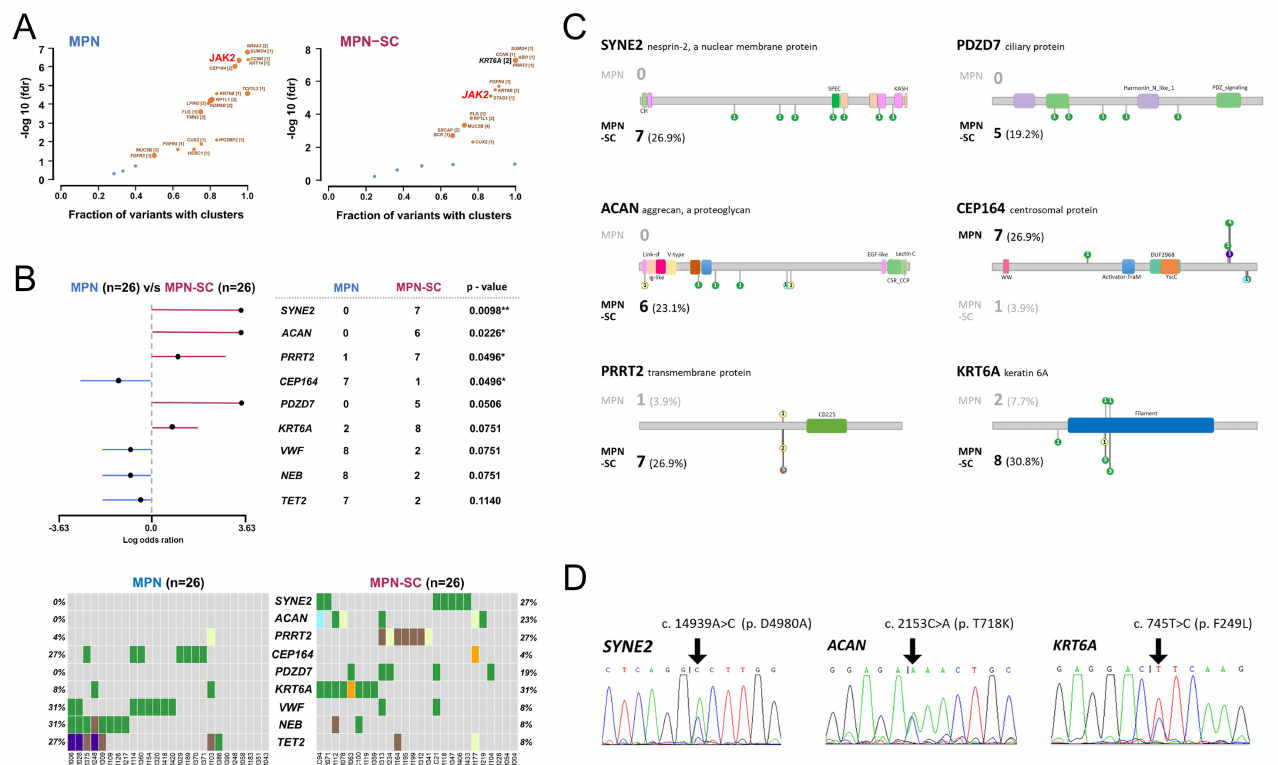
Figure 4. Significance and differences of various genes in MPN with an SC as compared with controls. ( A ) The significance and fraction of variants with clusters for each gene in both groups. Data were obtained with the OncodriveCLUST algorithm. ( B ) Genes differentially altered between the two groups of MPN patients. ( C ) Comparative lollipop diagrams of several key genes between the two groups of patients. Upper: MPN control group. Lower: MPN–SC group. Each lollipop indicates the position where a specific mutation occurs. Case numbers are shown in bold, and the prevalence of variants of a specific gene is described in parentheses. ( D ) Validation with Sanger sequencing. Three representative genes ( SYNE2 , ACAN , and KRT6A ) exhibiting variants predominantly seen in MPN patients with SCs on WES were selected, and DNA samples from involved patients were subjected to validation through Sanger sequencing. Arrows indicate the positions of the mutations. *: p < 0.05; **: p <